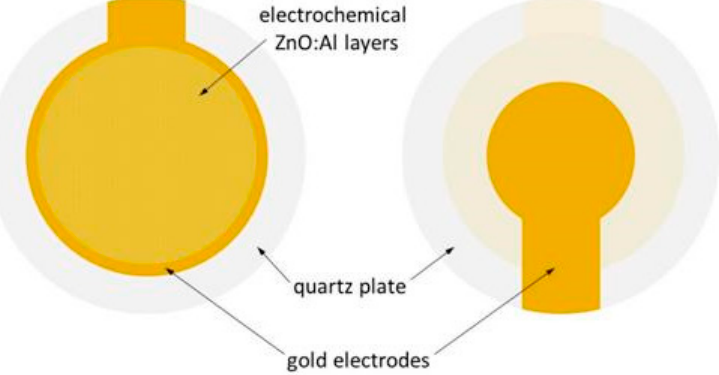
Figure 1. Configuration of the location of the gold electrodes and the electrochemically deposited ZnO:Al layer on the quartz resonator.